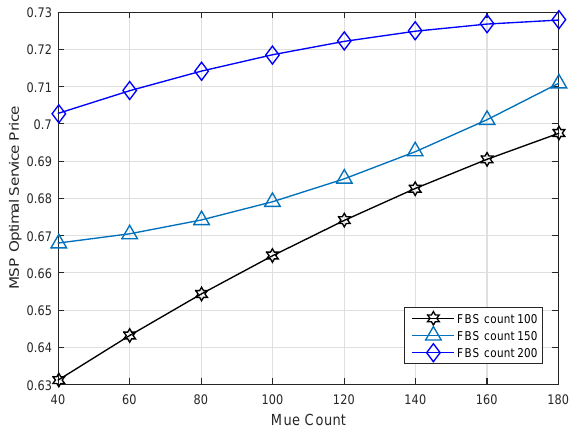
Figure 10. MSP optimal service price versus MUE count under different FBS